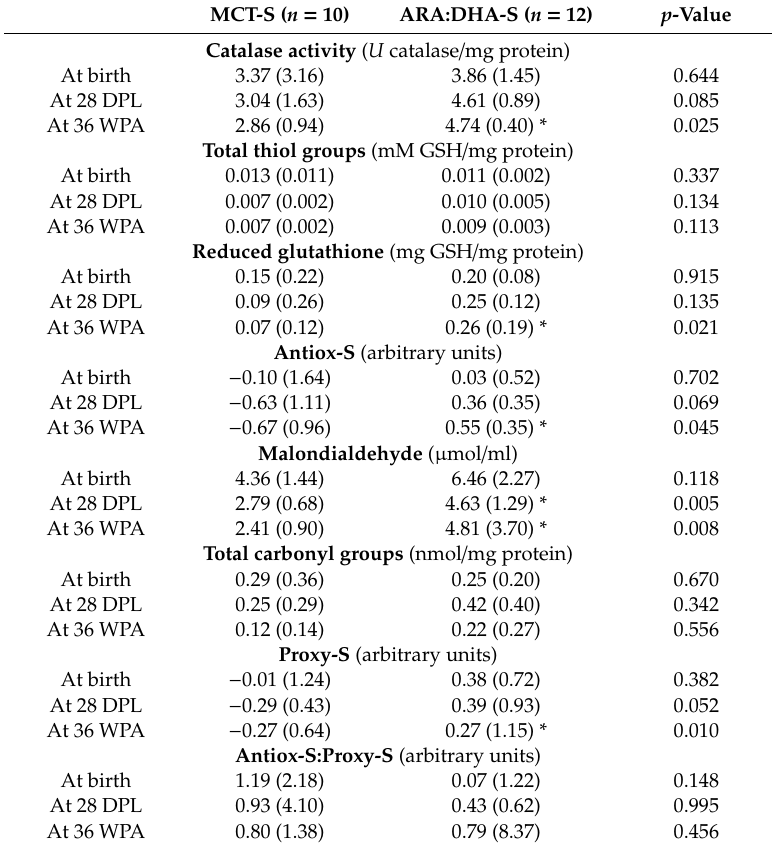
Table 4. Plasma oxidative status at di ff erent time points according to supplementation.